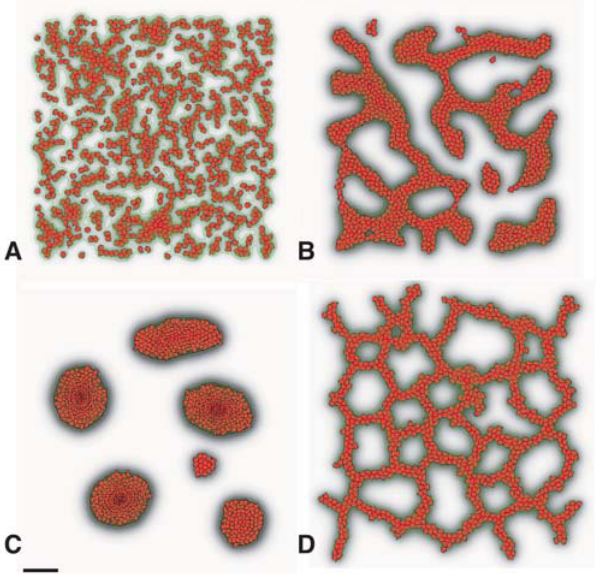
Figure 2. Endothelial cell aggregation; simulation initiated with 1000 scattered cells. (A) After 10 Monte Carlo steps ( MCS ) ( , 5 min). (B) After 1000 MCS ( , 8 h). (C) After 10,000 MCS ( , 80 h). (D) Contact-inhibited chemotaxis drives formation of vascular networks. Scale bar: 50 lattice sites ( < 100 m m). Contour levels (green) indicate ten chemoattractant levels relative to the maximum concentration in the simulation. Grey shading indicates absolute concentration on a saturating